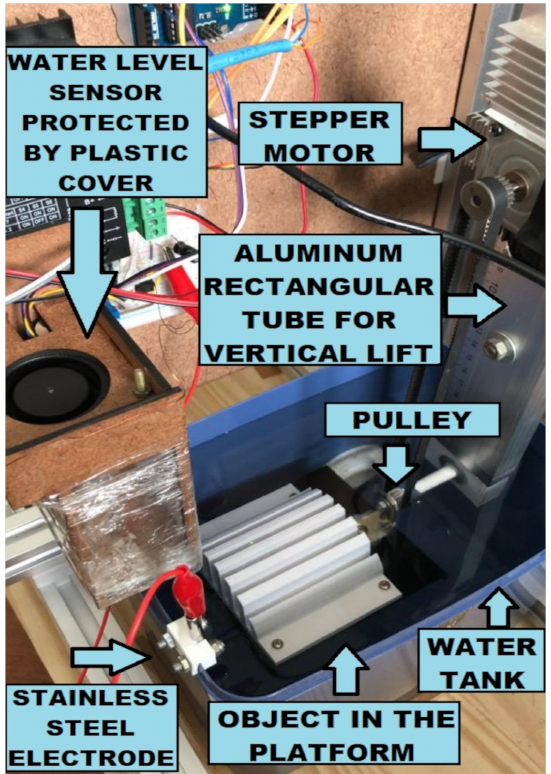
Figure 1. The mechanical setup of the 3D immersion scanner. The platform contains a white 3D printed model symmetric along its rotation axis. A pulley and a belt turn the platform with the object, while the aluminum tube lowers or lifts the